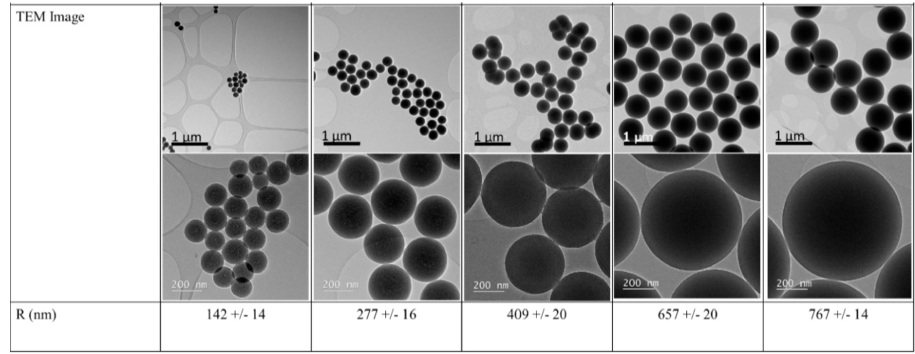
Figure 5. UNPS and drying measurements of the particle concentration of the Silica samples.